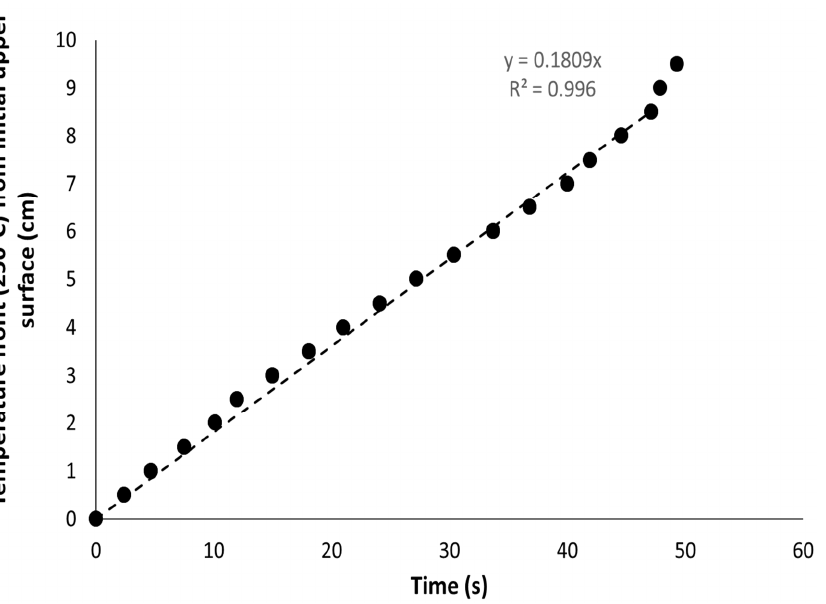
Figure 10. Evolution of the temperature front (measured by the IR camera) for the HD foam collapse during the cone calorimeter test at 35 kW/m 2 (sample thickness 10 cm)—The first point was fixed arbitrarily at 0 s and 0 cm.